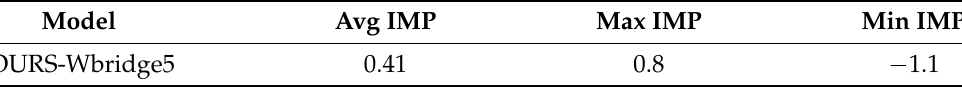
Table 4. Bidding strength